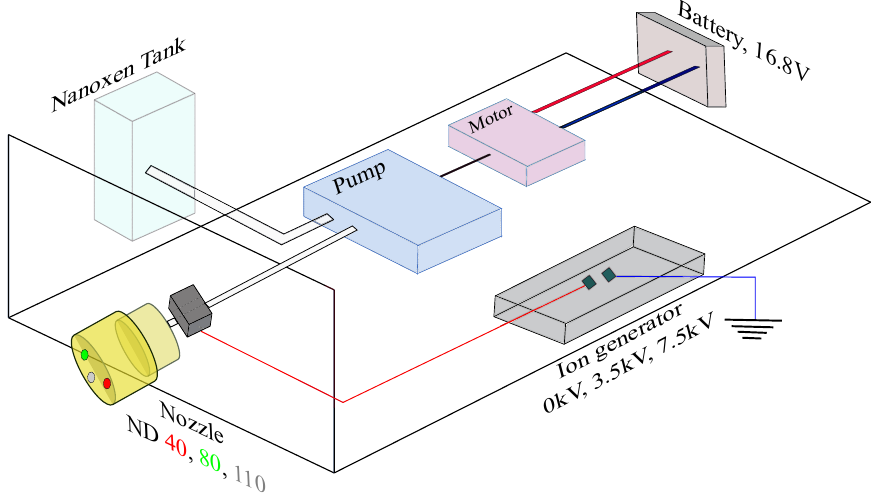
Figure 2. Electrostatic sprayer prototype.